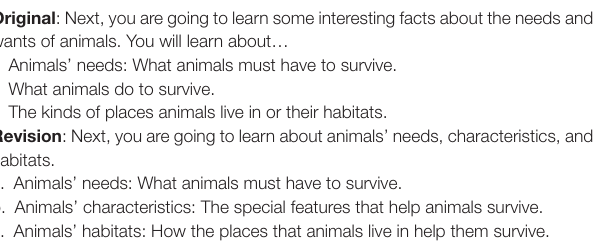
TABLE 5 | Example of revised instructions to enhance clarity for test